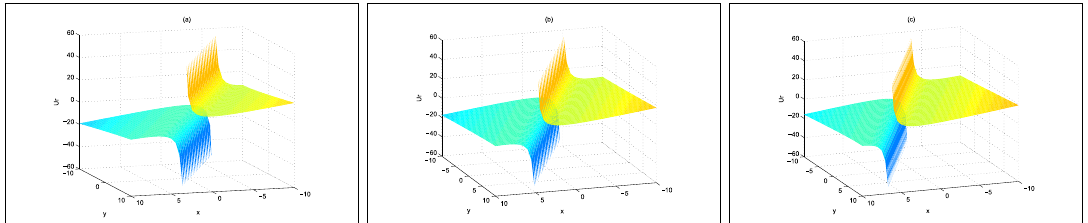
Figure 1: The solution of the ( 2 + 1 )- dimensional gCBS equation corresponding to ( ) U z r , ( a ) = t −3 , ( b ) = t 0 and ( c ) = t 3 .